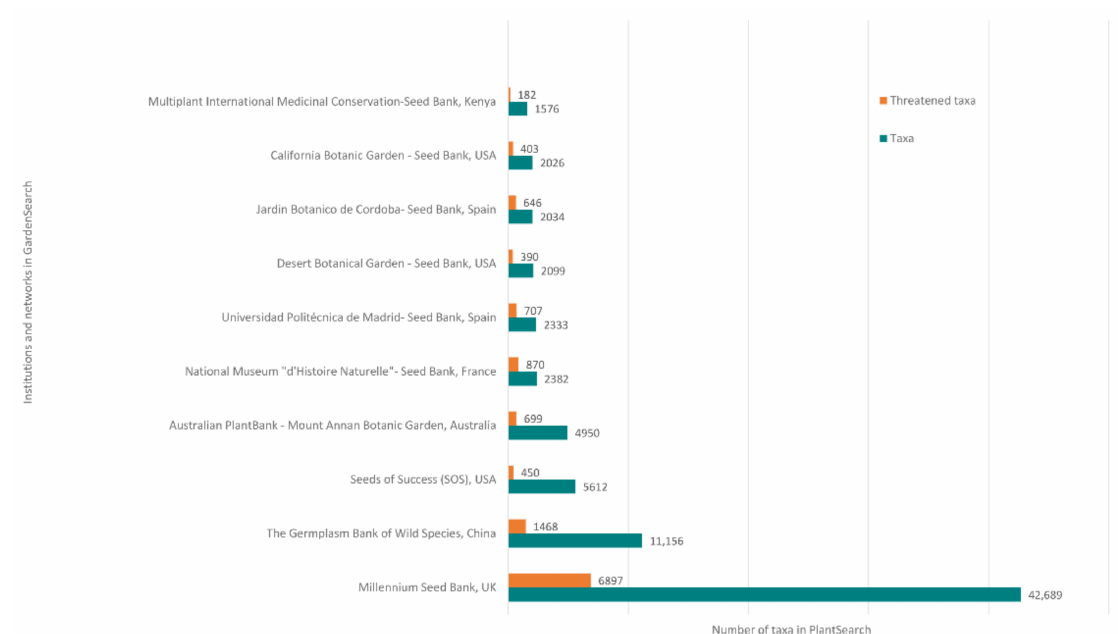
Figure 2. Seed collection holdings of the largest ten wild plant seed banks by the number of taxa stored based on PlantSearch data. Threatened taxa includes species categorised as threatened (including global, regional and national assessments) from data in